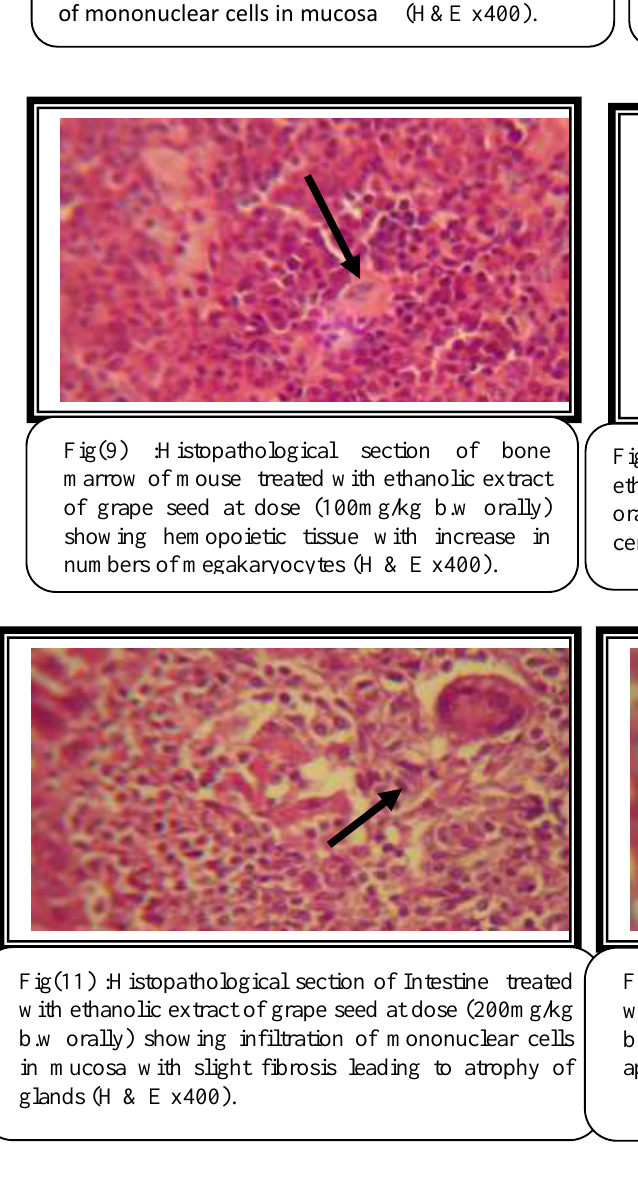
Fig(8) :Histopathological section of Intestine treated with ethanolic extract of grape seed at dose (100mg/kg b.w orally) showing hyperplasia of lymphoid tissue (H & E x400).